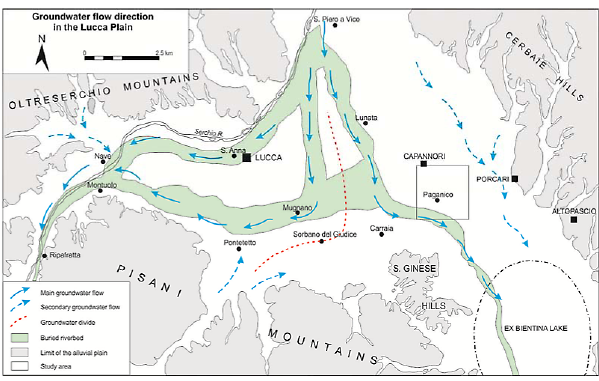
Fig. 4. Chief and secondary groundwater flow directions in the Lucca Plain (after Nardi et al., 1987, modified).